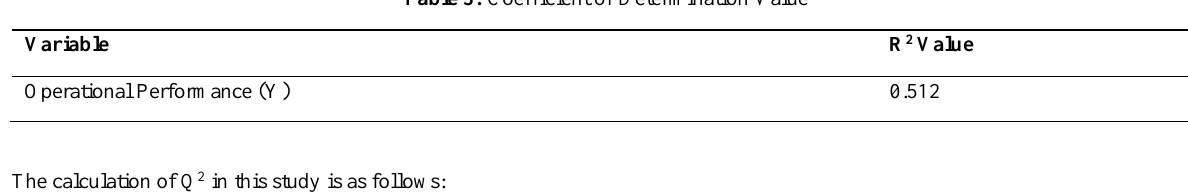
Table 3: Coefficient of Determination Value